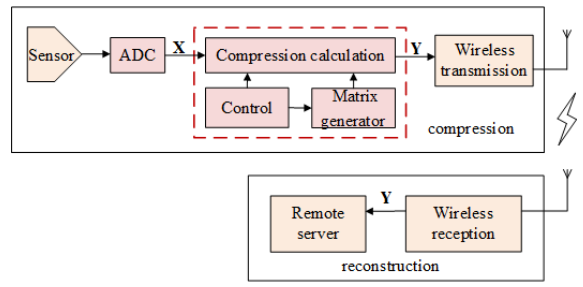
Figure 1. The processing system architecture based on CS.